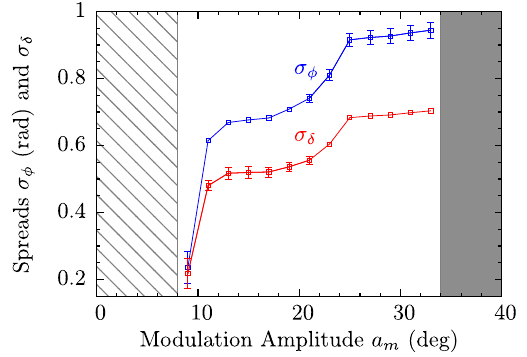
FIG. 16. The rms bunch spreads σ ϕ and σ δ as functions of FIG. 17. Poincaré surface of section depicting the diffusion of a ¼ 45 °. The hatched region modulation amplitude a where Δ ϕ ¼ 23 ° and Δ ϕ ¼ 45 ° just as the bunch m o small bunch where a m o depicts the approximate regions where no diffusion was ob- sizes sharply increase for the second time. Note the islands of the served. The solid band depicts the approximate region where 8 ∶ 3 resonance at the edge of the diffused structure just before beam loss was encountered. Data points where the error is much collapse and subsequent shrinking. less than 1% have negligible error bars.